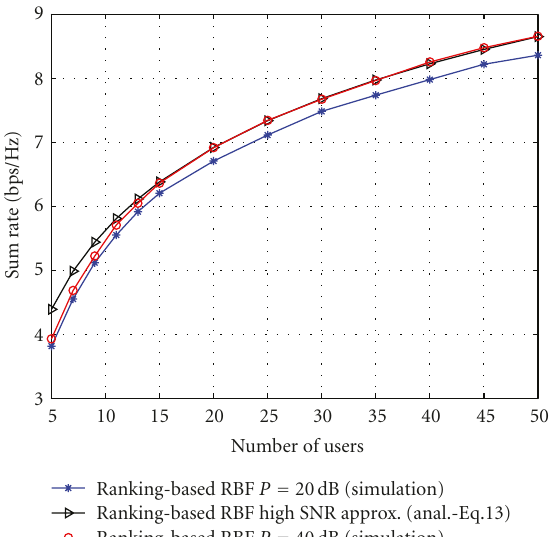
Figure 2: Sum rate performance comparison of analytic low SNR approximate solution (14) for RBF ( M = 4beams) using ranking- based CSIT as user selection metric to simulated results using Monte